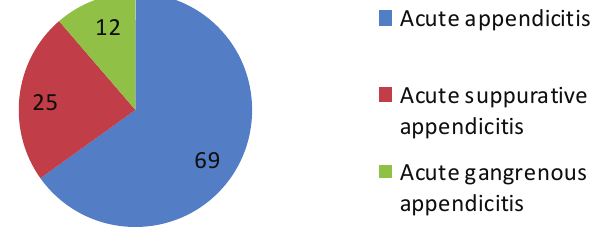
Figure 2: Histopathological